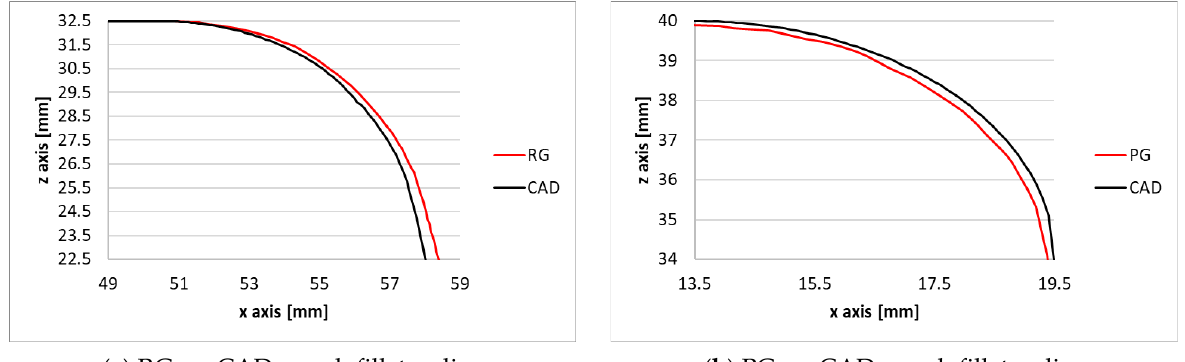
Figure 7. Main results of cup LP analysis.